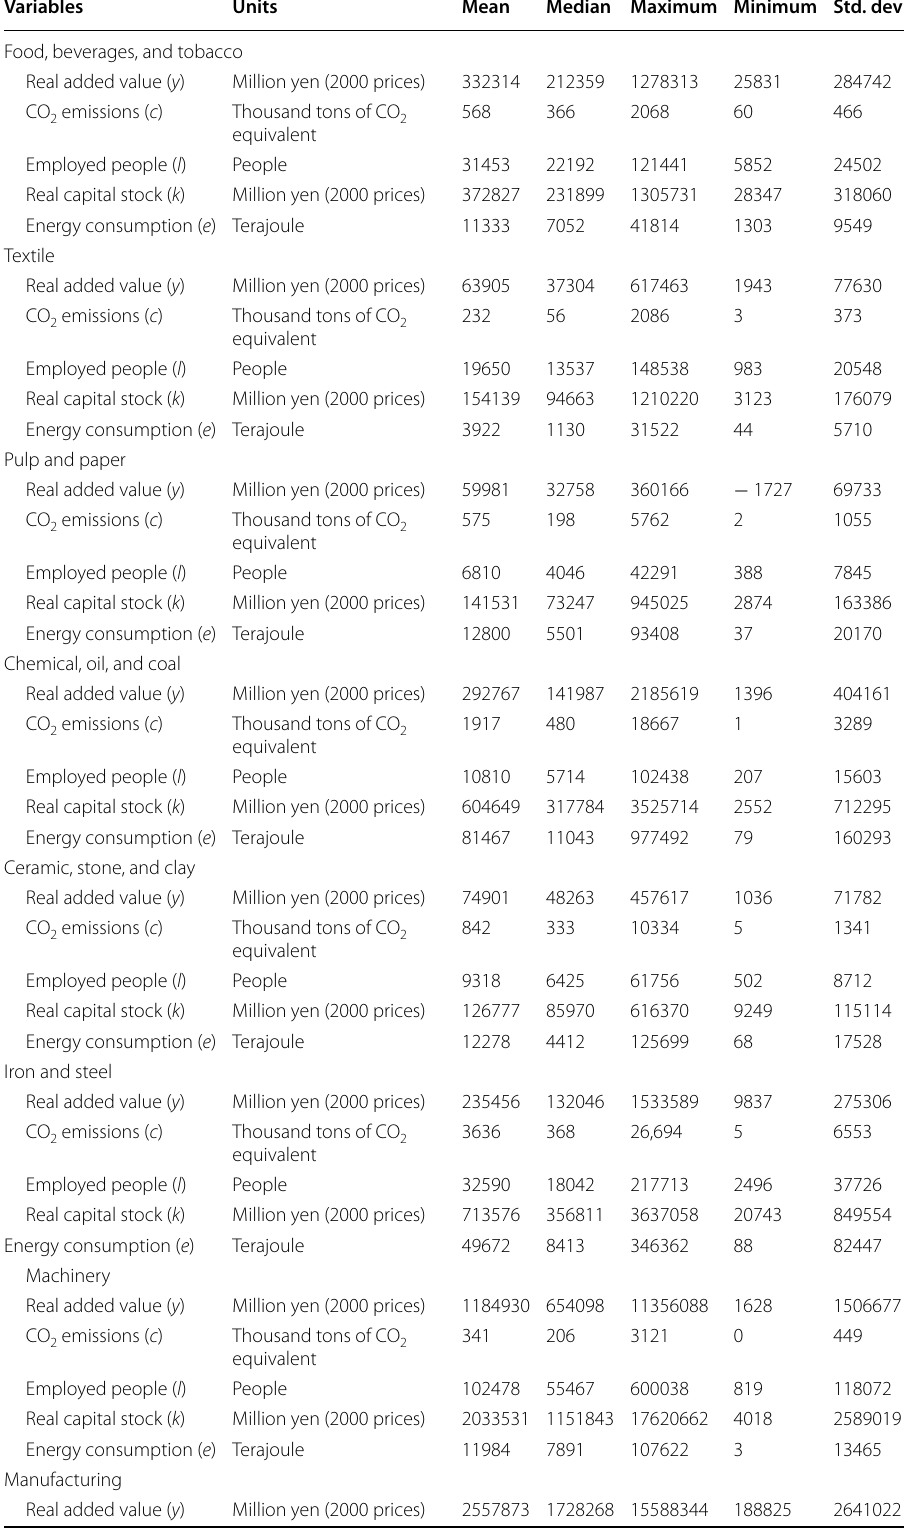
Table 1 Summary statistics of